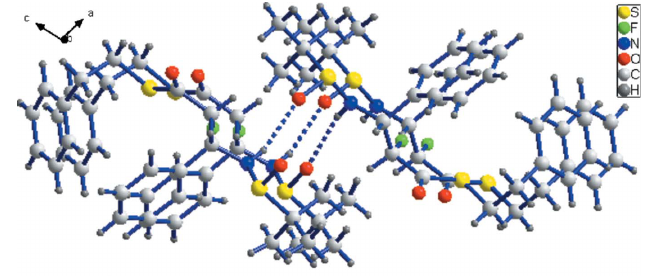
Figure 2 Partial packing diagram showing N—H (cid:4)(cid:4)(cid:4) O hydrogen bonds as dashed lines.